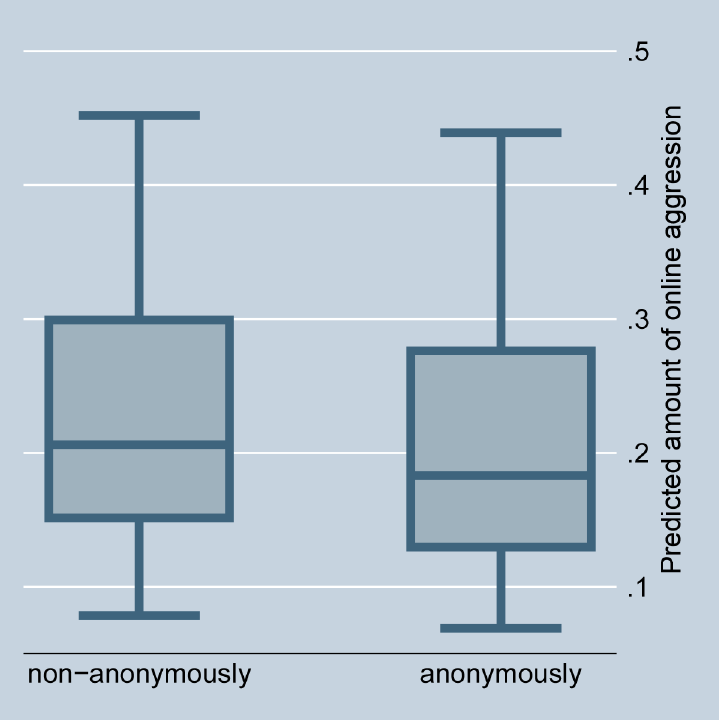
Fig 7. Online aggression dependent on anonymity of commenters (fixed-effects). Predictions of Table 2, Model